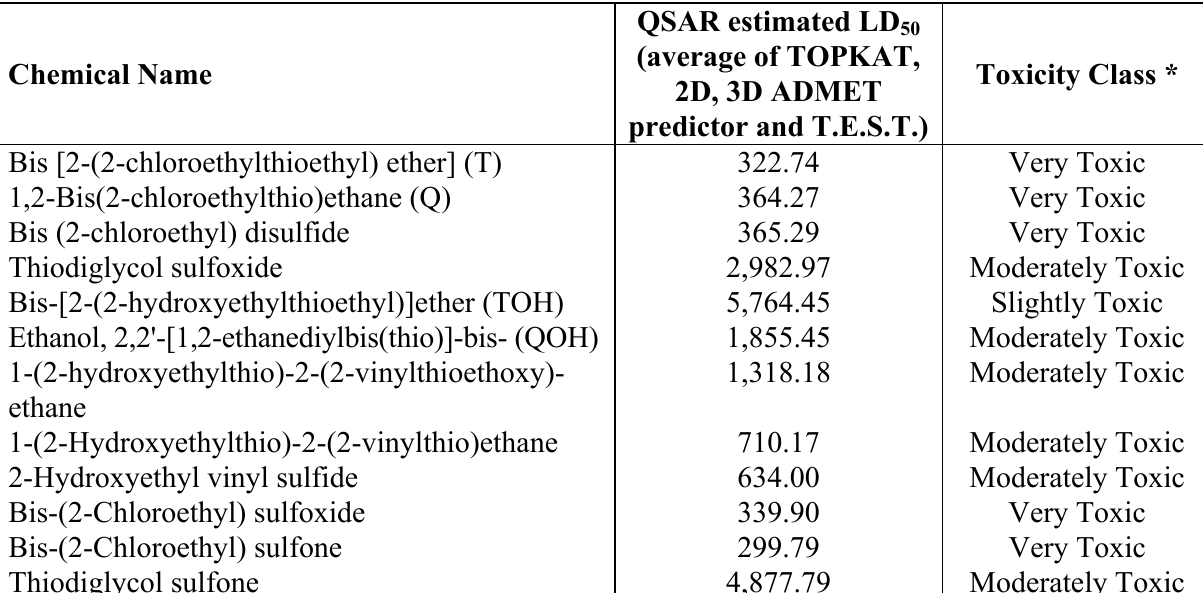
Table 4. Average estimated LD that lack of experimental LD